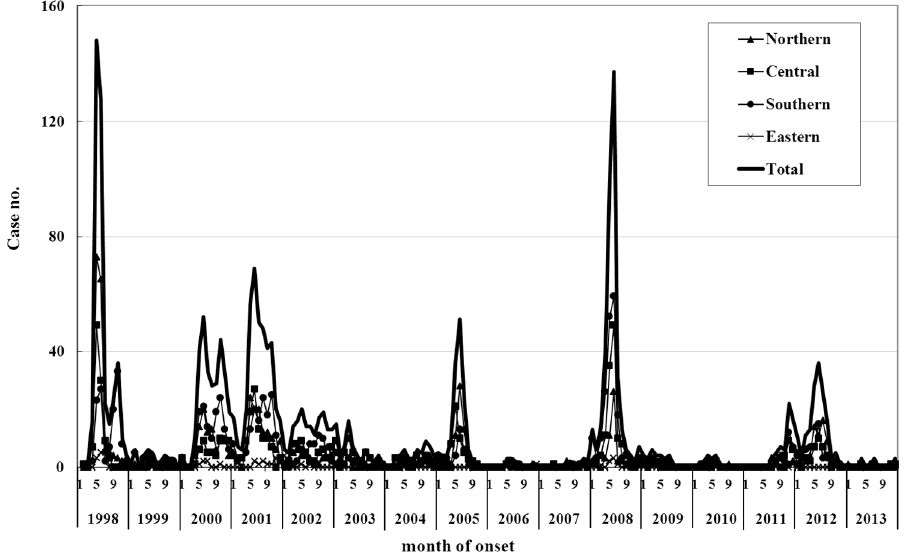
Figure 1. The number of cases of severe hand, foot, and mouth disease and herpangina in Taiwan, overall and by region, 1998–2013.